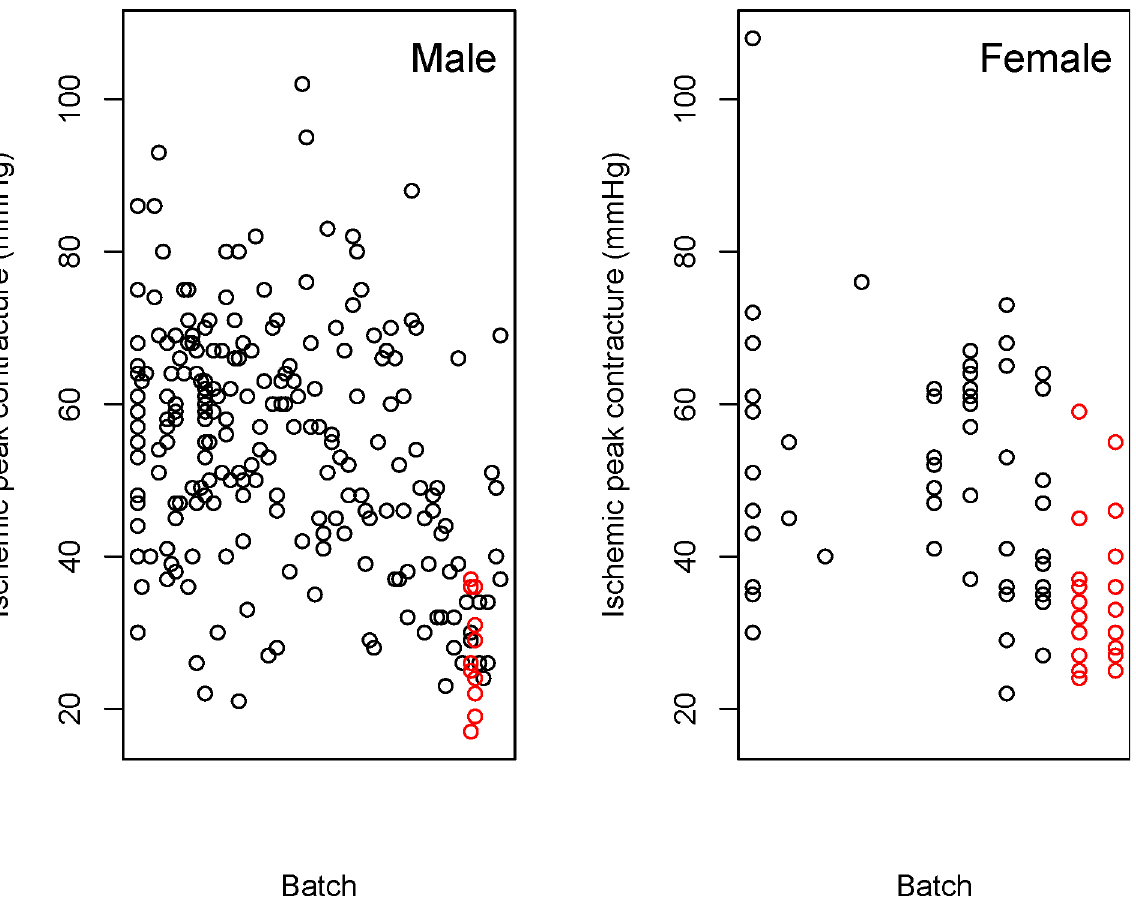
Fig 6. Example output of the PhenStat scatterplotGenotypeSexBatch function. Shown is the variation with batch in the peak contracture pressure readings for rats from SS strain (coloured in black) compared to the SS-3BN/Mcwi strain (coloured in red) visualised using the scatterplotGenotypeSexBatch function. This plot allows the user to visualize the batch variation and assess how the treatment effect compares to the observed batch variation. It is important to note that as dates can be entered in many forms, the batches are not ordered with time.